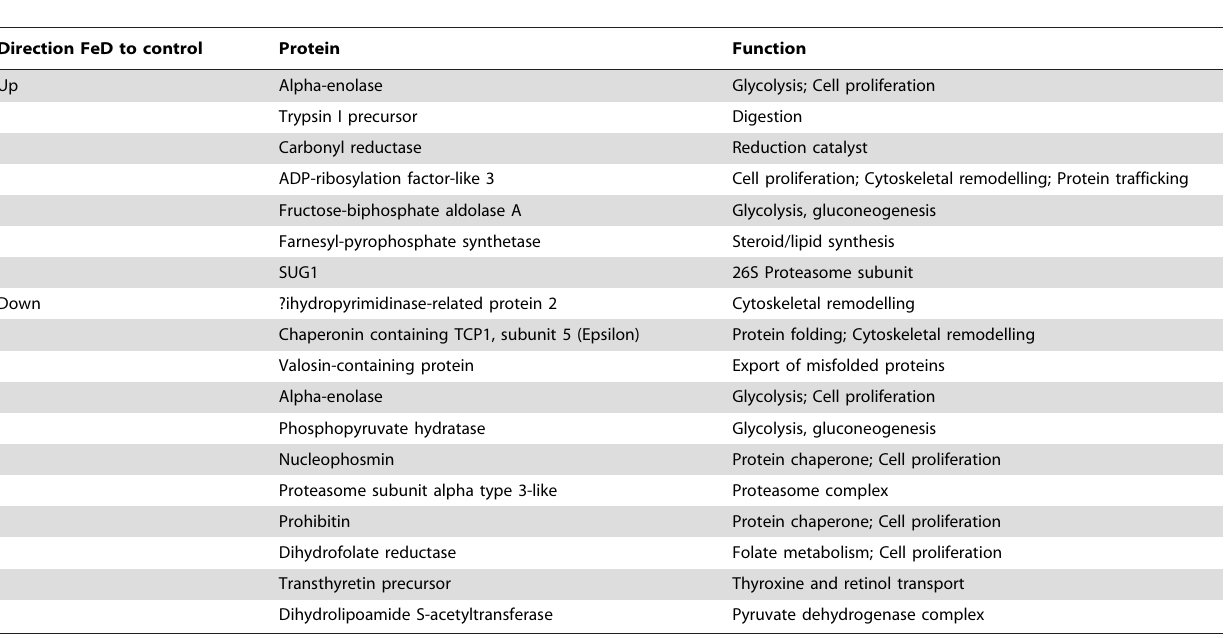
Table 4. Proteins identified to be significantly differentially regulated by mass spectrometry following 2D gel electrophoresis.